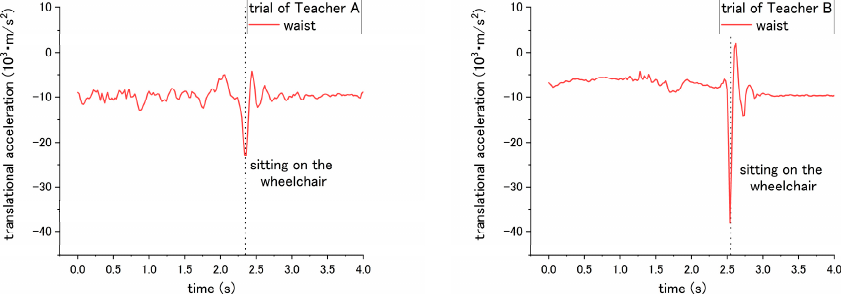
Figure 9. Translational acceleration of patient’s chest during step No. 15 through incorrect way conducted at step No. 14.